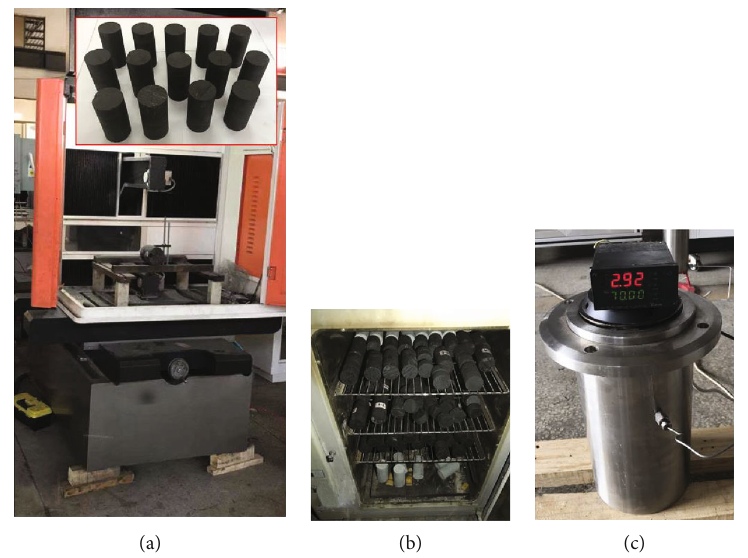
Figure 2: Coal sample preparation: (a) wire cutting; (b) drying oven; (c) pressure